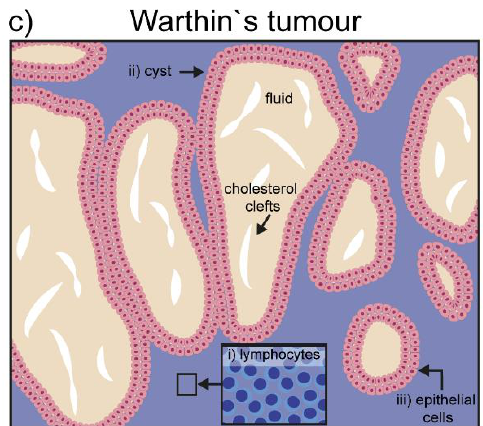
Figure 1. Schematic representation of hallmarks in benign salivary gland tumors: ( a ) Pleomorphic adenoma is characterized by three different cell types: (i) Plasmacytoid, (ii) epithelial cells, and (iii) myoepithelial cells; ( b ) oncocytoma is composed of a homogeneous mass of oncocytes bordered by fibrous connective tissue; ( c ) the papillary cystadenoma lymphomatosum or Warthin’s tumor, is characterized by its cystic components filled with amorphic fluid and occasional presence of cholesterol clefts; the major cellular components are lymphocytic infiltrates surrounding the